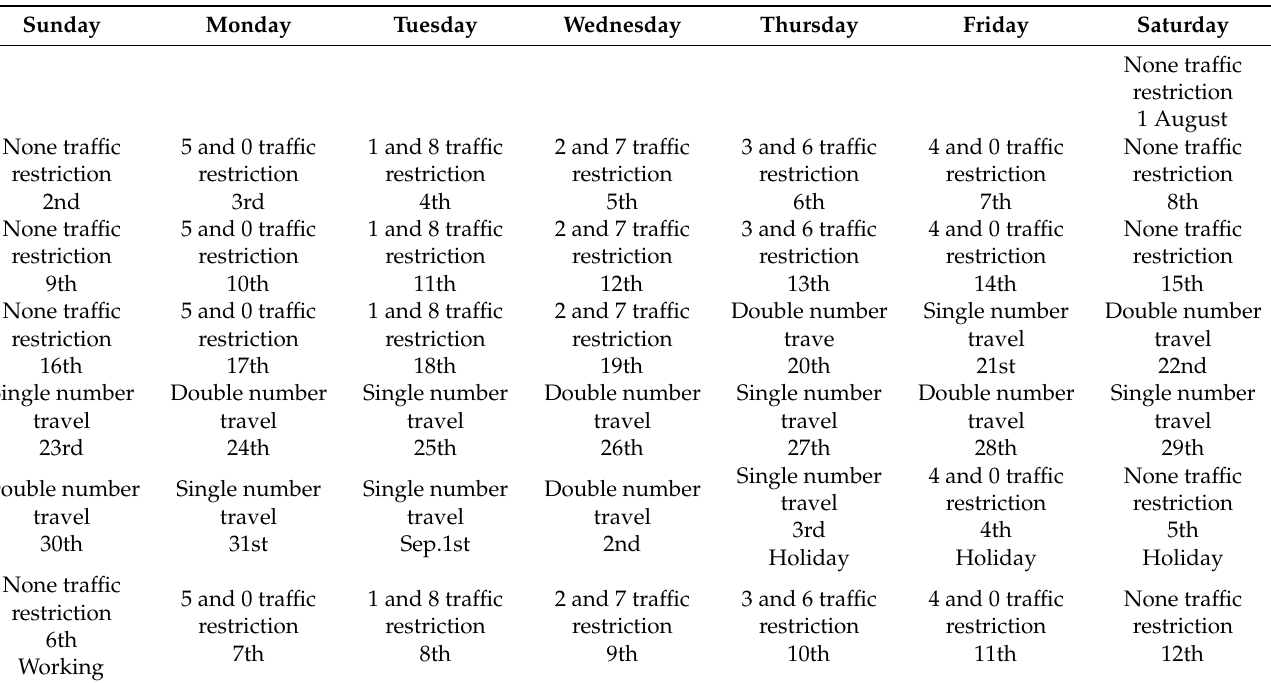
Table 1. Arrangement of single and double limit line time for Beijing motor